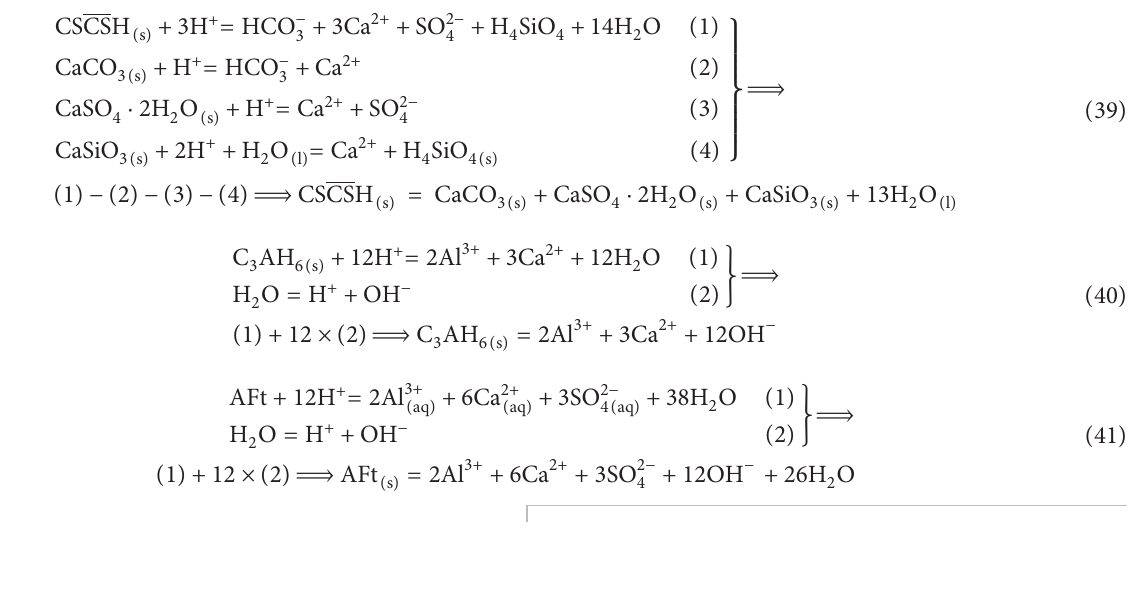
Figure 2: Curves of critical sulfate ion concentration and thermodynamic equilibrium constant with temperature. (a) Ca(OH) · 2H and CaSO 4 2